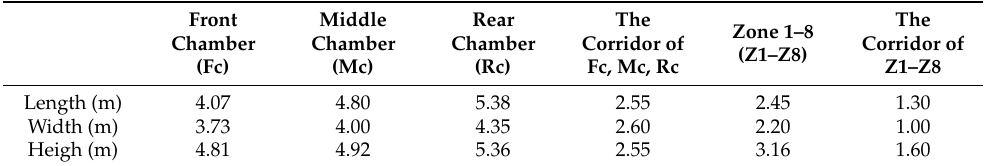
Figure 1. ( a ) Physical model of the Shun Ling; ( b ) arrangement of concentration sampling points and wind speed and temperature monitoring points. Table 1. The main specific size information of the Shun Ling in the Two Mausoleums of Southern Tang